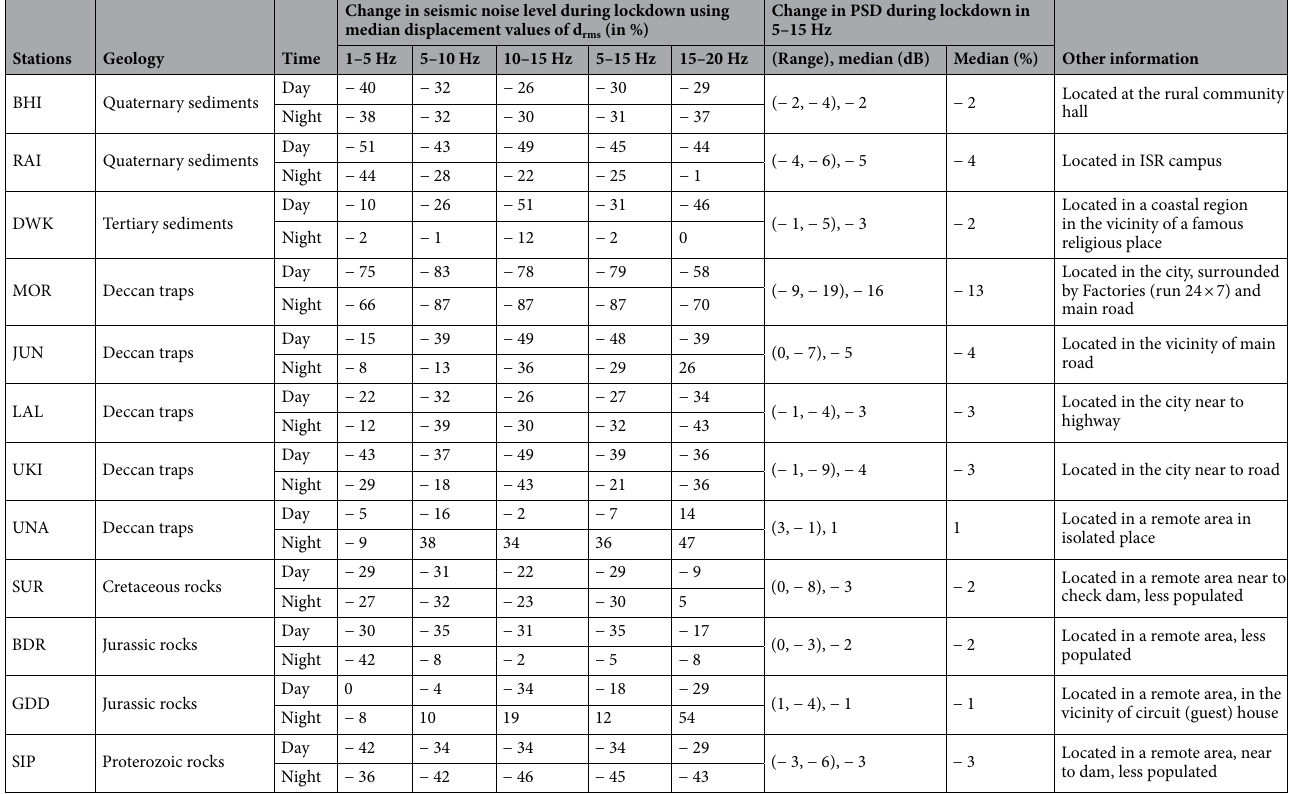
Table 1. Variation in the seismic noise level (in percentage) at different stations during the day and night times in the lockdown period, using the ground displacement values for different frequency bands between 1 and 20 Hz. Here, the difference during pre- and co-lockdown periods is estimated by considering the median values for the estimated periods. Negative values indicate a drop in the seismic noise level (in %) during co-lockdown period with respect to the pre-lockdown, i.e., increase in the anthropogenic noise during the lockdown period. The changes in PSD are also calculated using median values for the pre- and co-lockdown periods. The range of change in PSD (in dB) in the 5–15 Hz frequency range during lockdown with respect to pre-lockdown is also listed. Here, the amplitude of PSD difference represents the absolute change and negative sign indicates a drop in PSD amplitude during the co-lockdown with reference to the pre-lockdown. The median values for the change in PSD (in dB and %) are also provided. The subsurface geology at different stations and other local conditions are also illustrated. Here, change in PSD [dB] = median ( PSD ) co − lockdown − median ( PSD ) pre − lockdown , and change in calculation, the pre-lockdown duration is considered from 01/03/2020 to 24/03/2020 and co-lockdown from 25/03/2020 to 19/04/2020 for the stations, except for RAI. For station RAI, co-lockdown duration